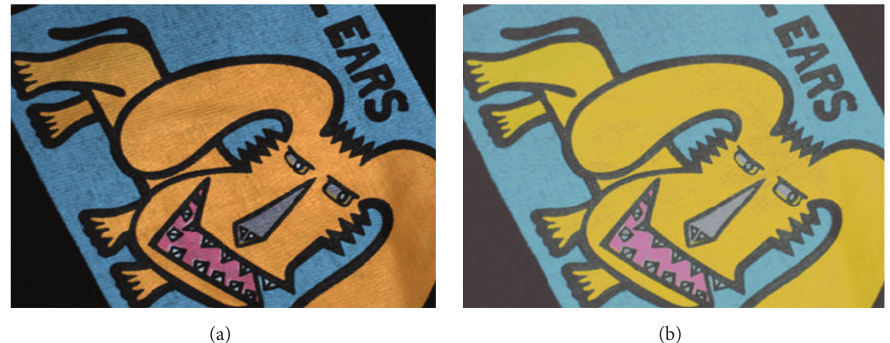
Figure 9: The images of printed matter of clothes. (a) Before calibration and (b) after